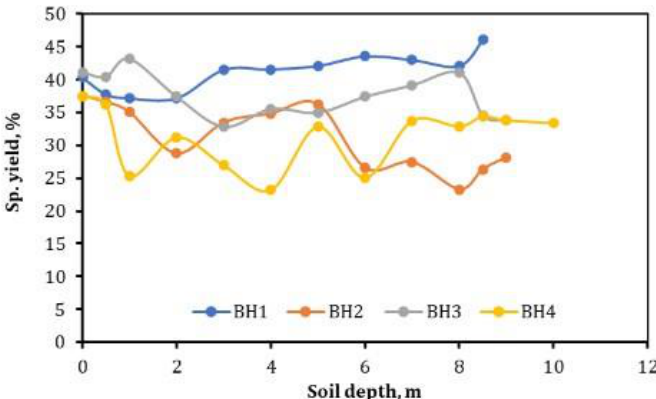
Figure 6. Variation of specific yield with respect to depth.